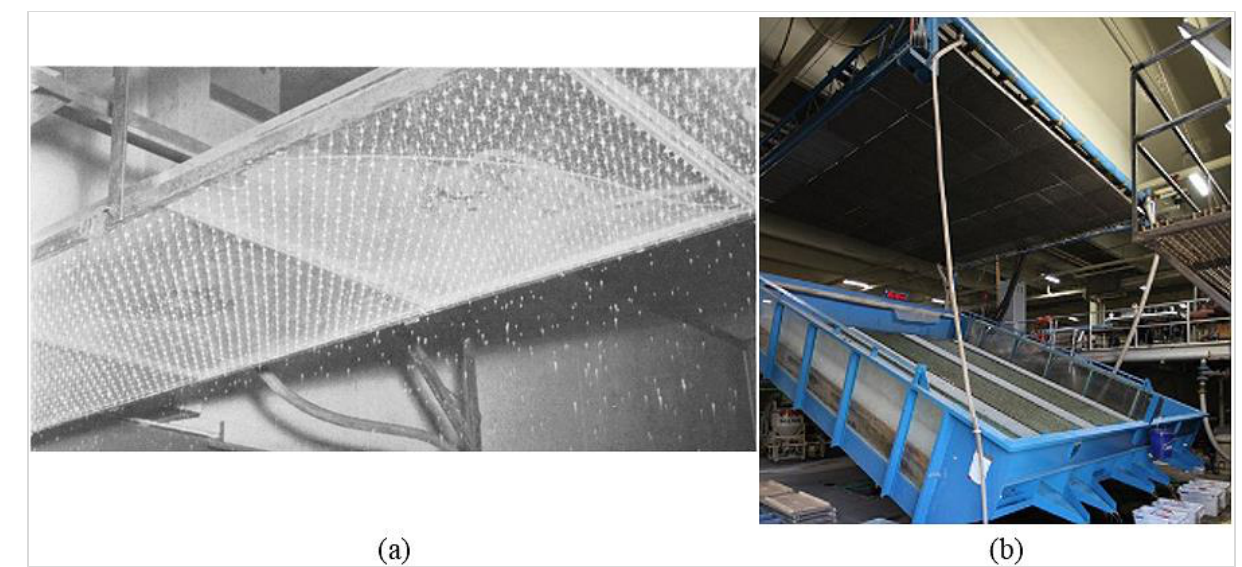
Figure 8. ( a , b ) Modular design of rectangular box water tank with drippers [17,206] (Utah State University/Utah Water Research Laboratory. Available online: https://uwrl.usu.edu/hydraulics/hydraulic-testing (accessed on 19 August 2022)).